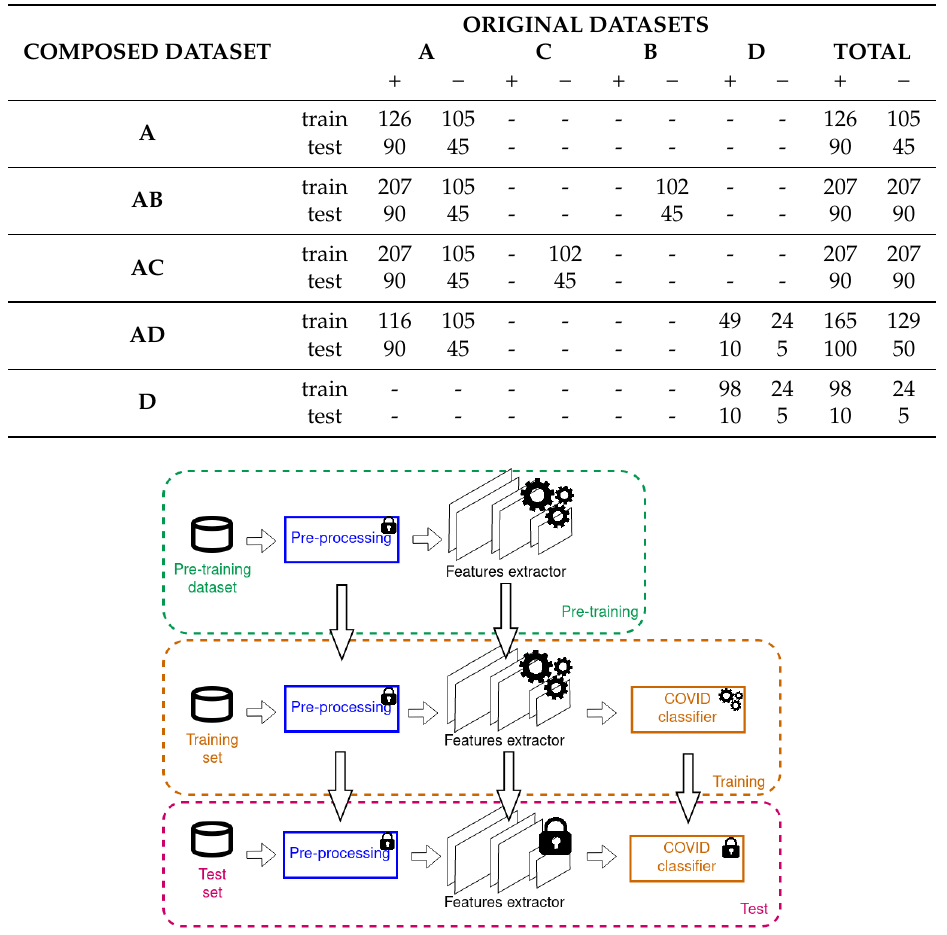
Table 1. Composition of datasets used for training and test are shown in the rows, with details on number of images taken from different sources in the columns; the COVID-positive samples are indicated as “+” while the negative ones with “−”. For better readability, each data source is identified by a letter: CORDA (A), ChestXRay (B), RSNA (C) and COVID-ChestXRay (D).